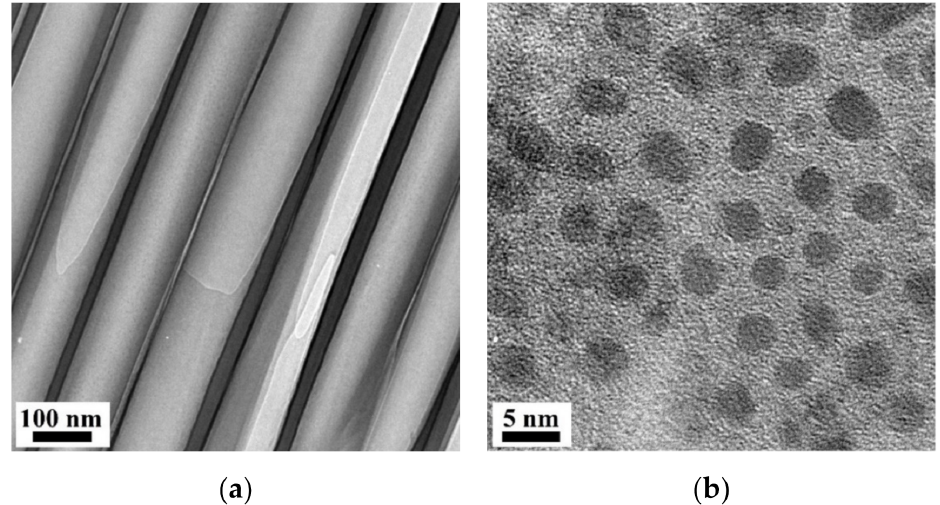
Figure 1. Pt/AAO catalyst before catalytic hydrogen combustion (CHC): ( a ) TEM bright-field image of cross-sectioned AAO pore channels; ( b ) HRTEM image of interpore-channel Pt